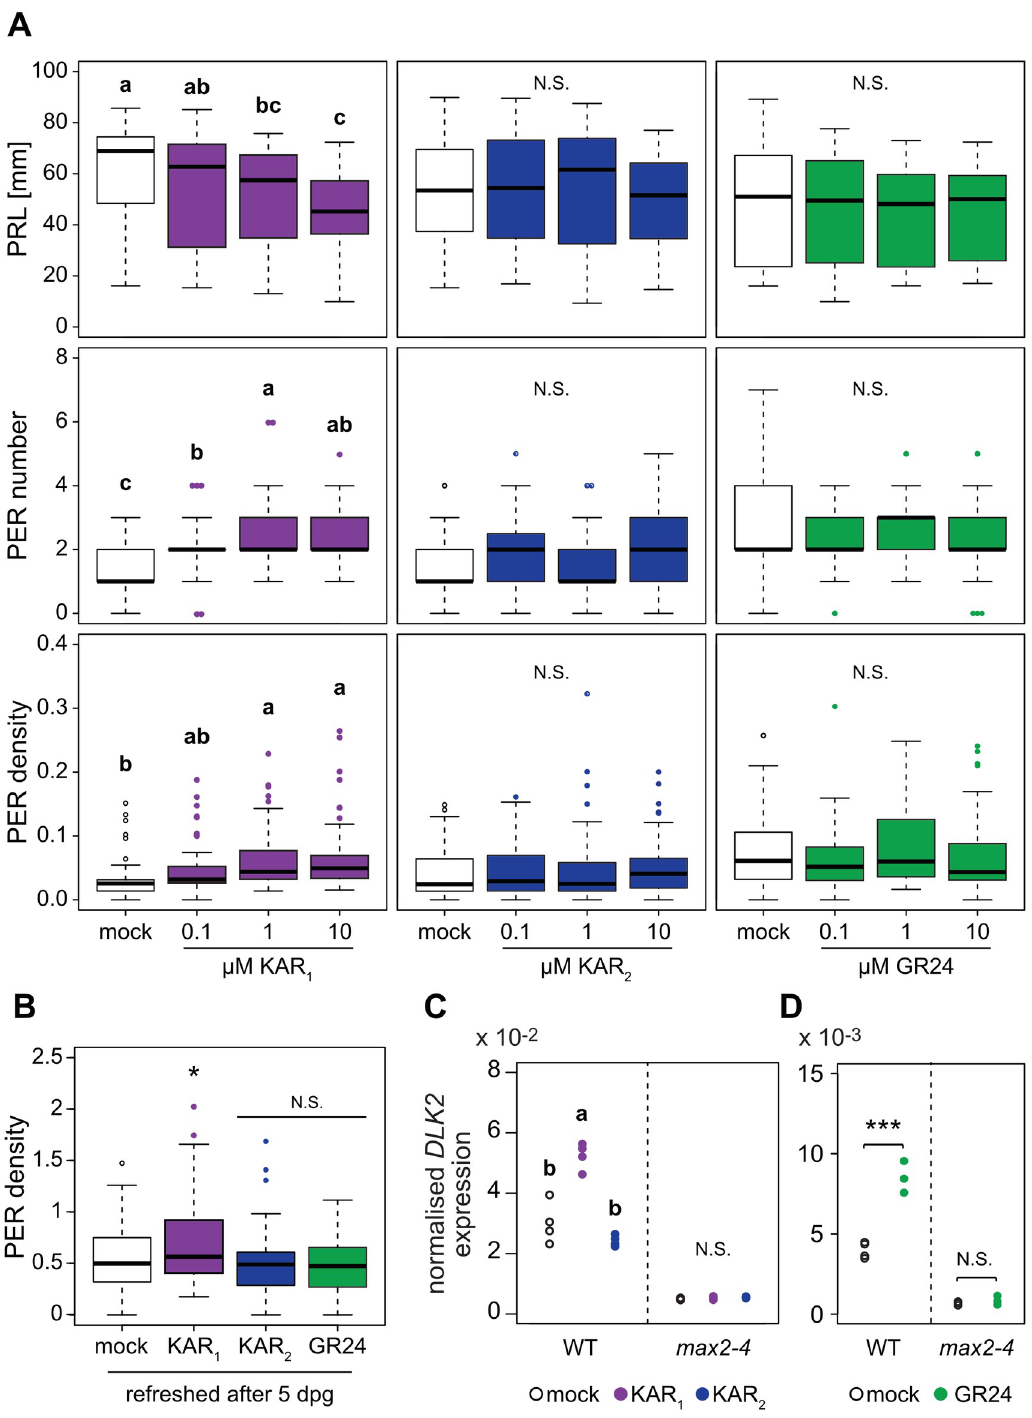
Fig 7. Lotus japonicus root system architecture is affected specifically by treatment with KAR 1 but not KAR 2 . ( A ) Primary root length (PRL), post-embryonic root (PER) number and PER density of wild-type plants 2 wpg after treatment with solvent (M) or three different concentrations of KAR 1 , KAR 2 or rac -GR24 (GR24) (n = 32–57). ( B ) PER density of wild-type plants at 2 wpg and treated with solvent (Mock) 1 μ M KAR 1 , 1 μ M KAR 2 , or 1 μ M rac -GR24 (n = 43–51). Plants were transferred onto fresh hormone-containing medium after 5 days. ( C-D ) RT-qPCR-based expression of DLK2 normalized to Ubiquitin expression in roots at 2 wpg after 2 hours treatment with solvent (Mock), ( C ) 1 μ M KAR 1 and 1 μ M KAR 2 , ( D ) 1 μ M rac -GR24 (n = 4). ( A and C ) Letters indicate different statistical groups (ANOVA, post-hoc Tukey test). ( B ) Asterisks indicate significant